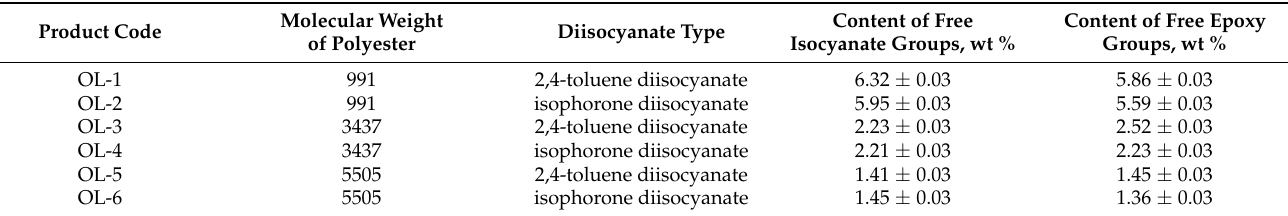
Table 2. Composition and properties of the synthesized oligomers.